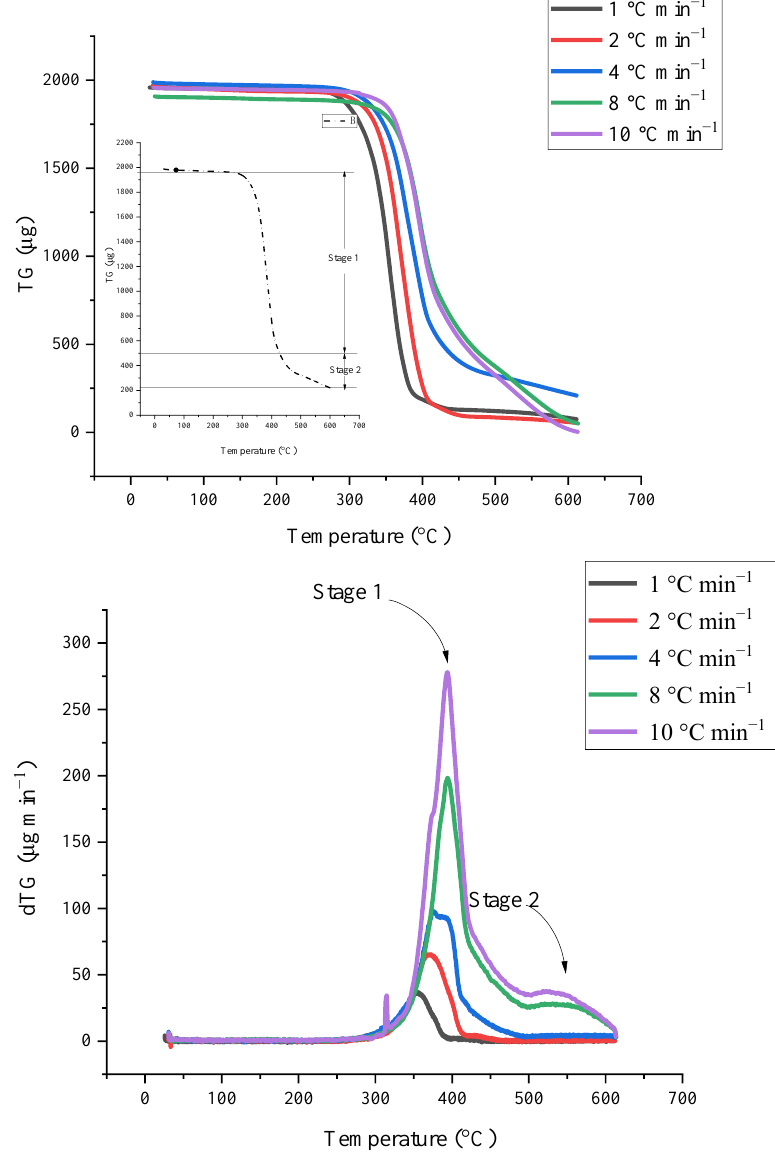
Figure 2. Mass loss and mass loss rate of [BZMIM][TF2N] by TGA results with different heating rates at 1.0, 2.0, 4.0, 8.0, and 10.0 °C min −1 .